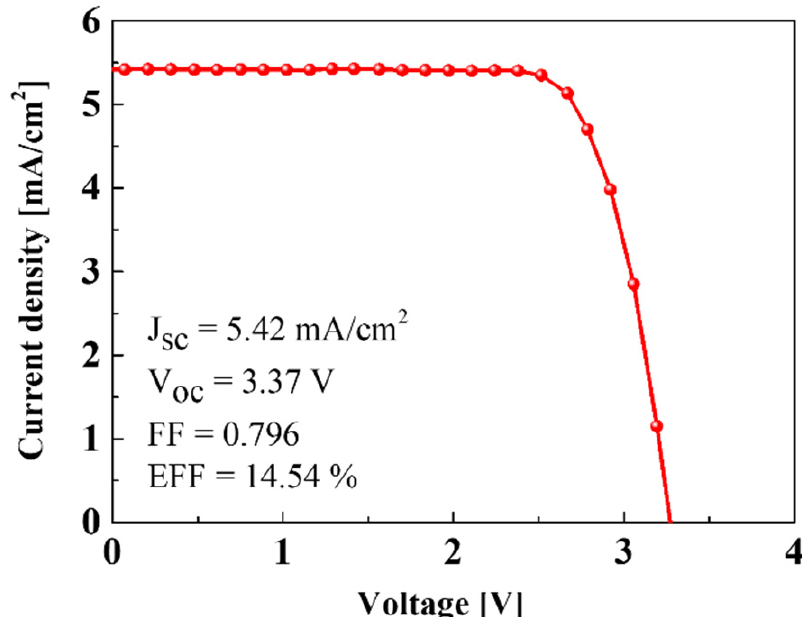
Figure 6. J-V curve of the Si solar cells.